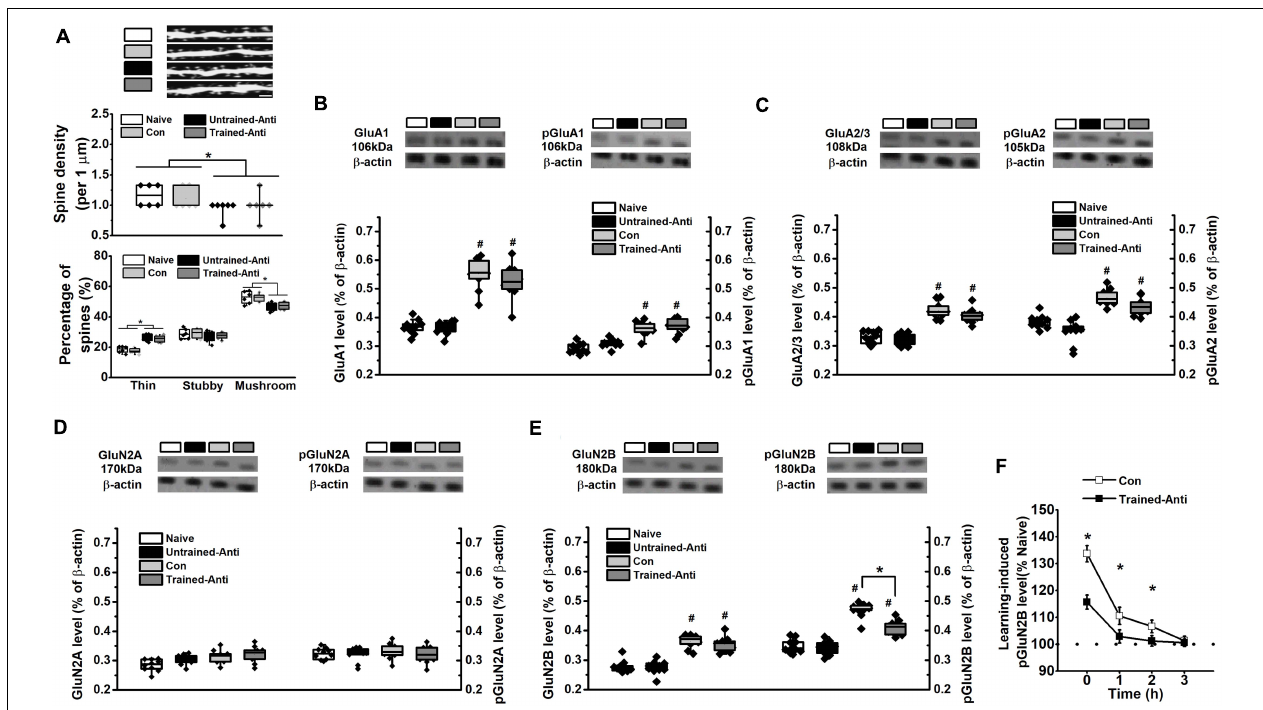
FIGURE 3 | Blocking proBDNF reduces spine number and learning-related GluN2B expression. The samples from rats that performed spatial training in the MWM task were collected immediately following the training phase and selected for detecting spine density and the expression of glutamatergic receptor subunits. (A) Spine alteration in naive, untrained-antiproBDNF, trained control, and trained-antiproBDNF rats (top). Quantification of spine density (middle) and the proportion of spine (bottom). Scale bars, 5 µ m. n = 6 per group. Sample images were projected at minimal intensity and inverted, background was then subtracted, followed by brightness/contrast adjustment. The expression and phosphorylation of GluA1 (B) and the expression of GluG2/3 and the phosphorylation of GluA2 (C) of AMPAR subunits. n = 10 per group. The expression and phosphorylation of GluN2A (D) and GluN2B (E) of NMDAR subunits. (* p < 0.05, Con vs. Trained-Anti; # p < 0.05, vs. matched Naive and Untrained-Anti). n = 10 per group. Note that the data of dendritic spine and glutamatergic receptors tests were subjected to a two-way ANOVA in which training status (trained or not trained) and treatment (anti-proBDNF antibody, ACSF, or no treatment) were dependent variables. (F) The expression of pGluN2B immediately, 1, 2, and 3 h following spatial training. (* p < 0.05, Con vs. Trained-Anti). n = 10 per group.